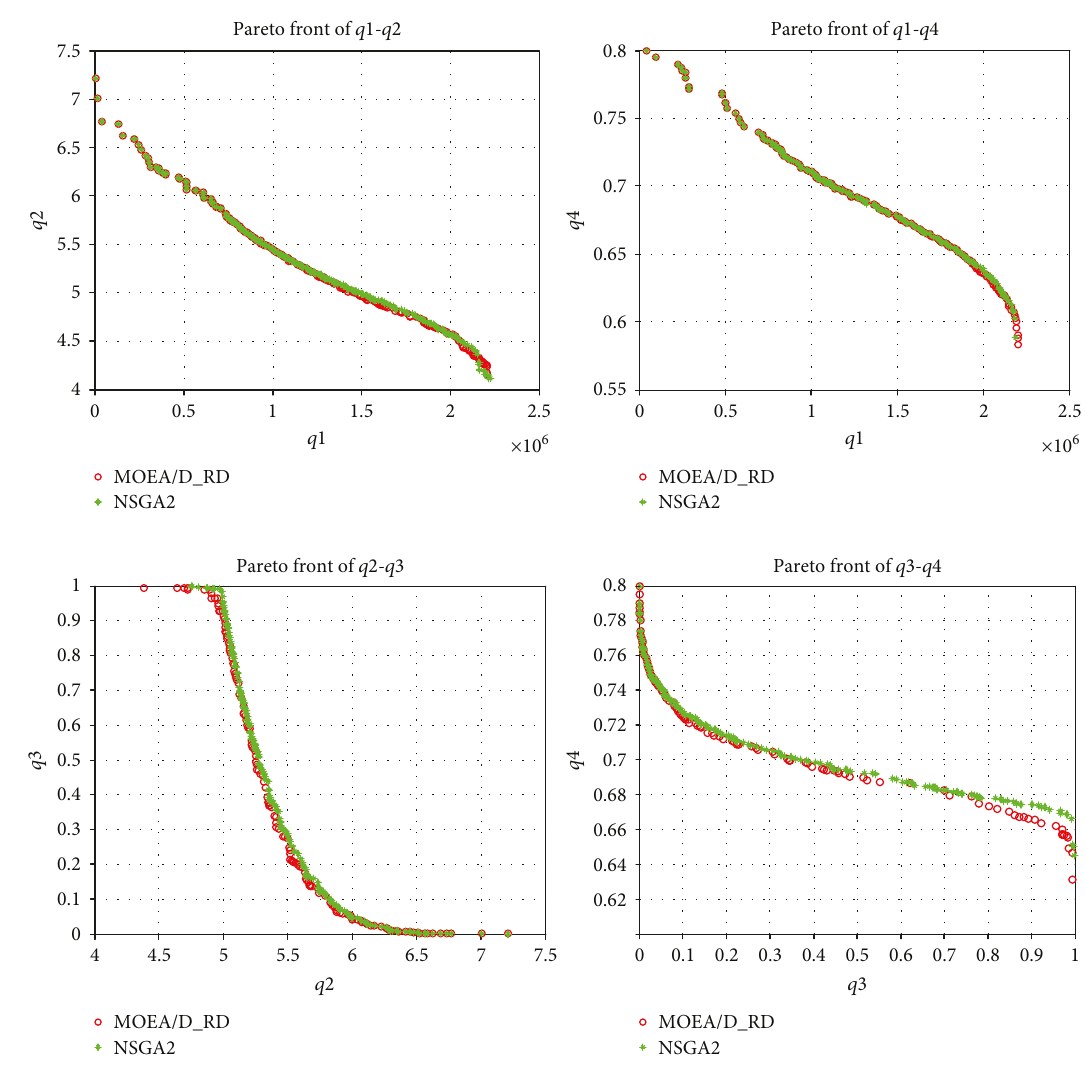
Figure 12: Comparison of PF between MOEA/D_RD (red circle) and NSGA2 (green ∗ ) for 2-objective